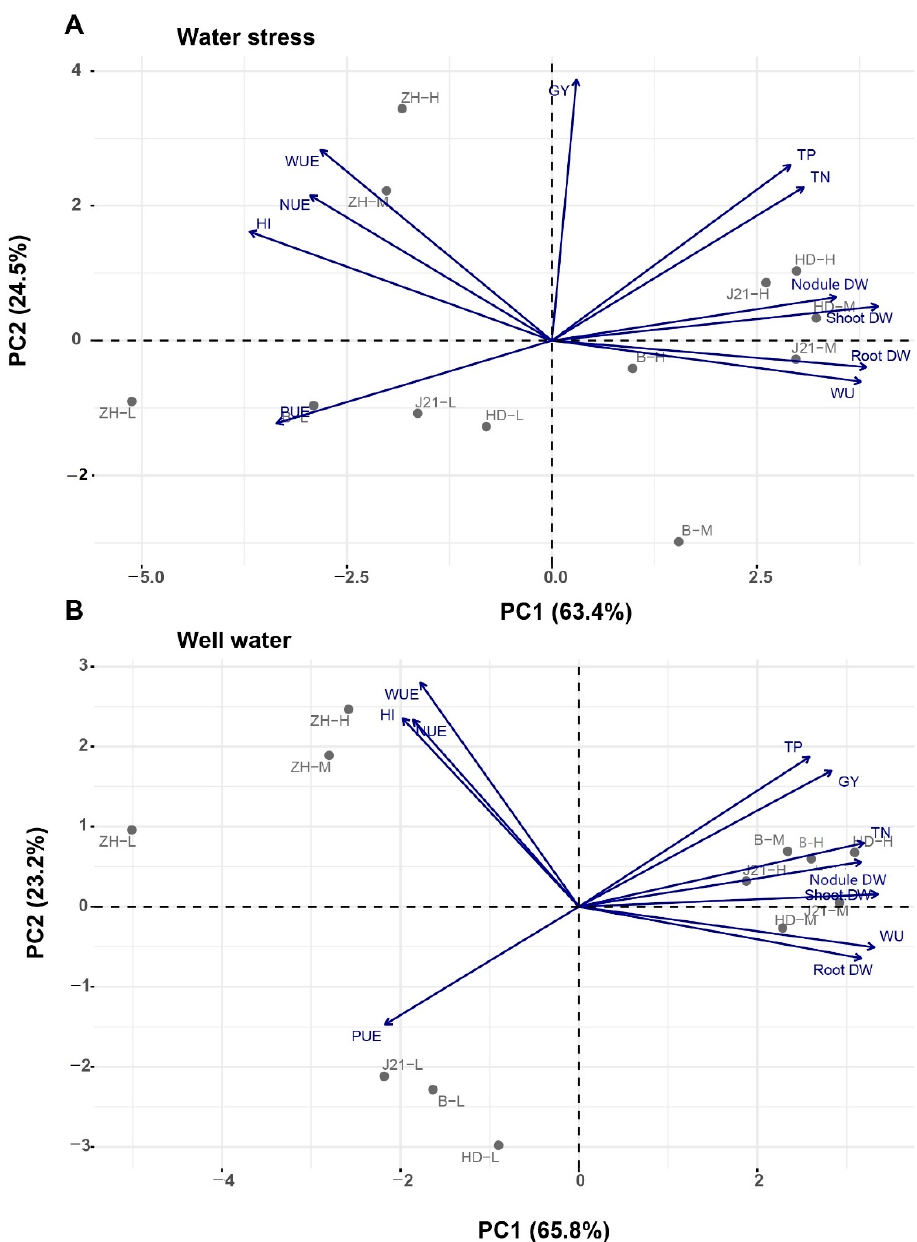
Figure 5. Principal component analysis of 11 traits in four soybean genotypes [B (Bailudou), HD (Huangsedadou), J21 (Jindou 21), and ZH (Zhonghuang)] under two water treatments [cycle water stress ( A ) and well-watered ( B )]. The 11 traits (vectors indicated by blue arrows) and each genotype with different P level were loaded on the first and second axes. The letters indicating traits are same as Figure 5; the letters after each genotype indicate P level [L, low P supply (P0), M, mid P supply (P60), H, high P supply (P120)].